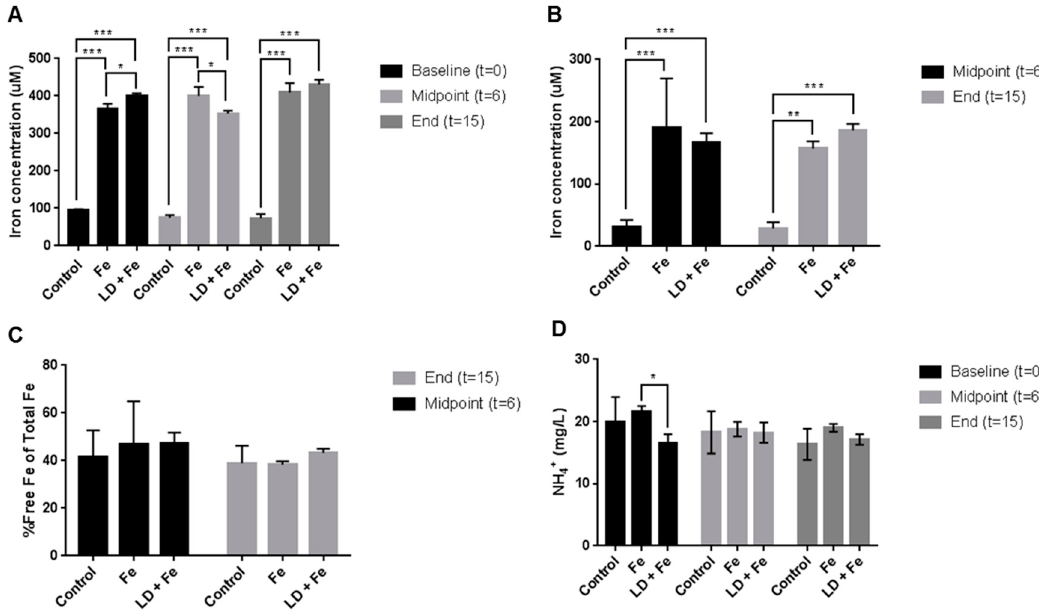
Figure 5. Iron and ammonium parameters within SHIME colonic vessels. Total iron ( A ) was measured across three time points (baseline, midpoint and at the end of the study) in the control, iron (Fe) and iron with MLD (MLD + Fe) vessels ( n = 3). Free iron ( B ) was also measured at the midpoint and the end. The percentage of free iron with respect to total Fe was also calculated ( C ). Ammonium concentrations were also measured across three time points ( D ). Bars represent mean values with error bars denoting standard deviations in the error. Statistical significance (using 1way ANOVA tests) is represented with an *, ** or **, where p < 0.05, 0.005 and 0.0005 respectively, with n = 3 for each mean value.